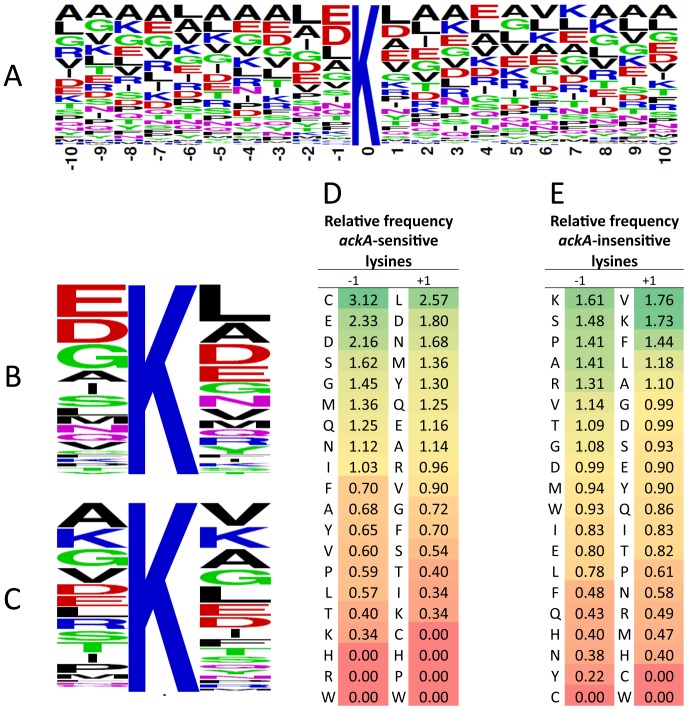
Analysis of the amino acid composition and position relative to acetylated lysines.
A) Using WebLogo, a consensus sequence logo was generated showing the amino acid composition in positions −10 to +10 relative to 541 ackA-sensitive lysines (i.e., robustly, significantly and reproducibly more acetylated in the ackA mutant relative to WT (ackA/WT ratio >2 with a p-value<0.05 in at least 3 out of 4 biological replicates). Using WebLogo, consensus sequence logos were generated showing the amino acid composition in positions −1 and +1 relative to B) ackA-sensitive lysines and C) ackA-insensitive lysines from 4 proteins (LpdA, PflB, AceE, GroL). The relative frequencies were determined by comparing the frequency of each amino acid in positions -1 and +1 adjacent to the D) 45 ackA-sensitive lysines and E) the 131 ackA-insensitive lysines to the overall frequency of each amino acid in all 4 proteins (LpdA, PflB, AceE, GroL).